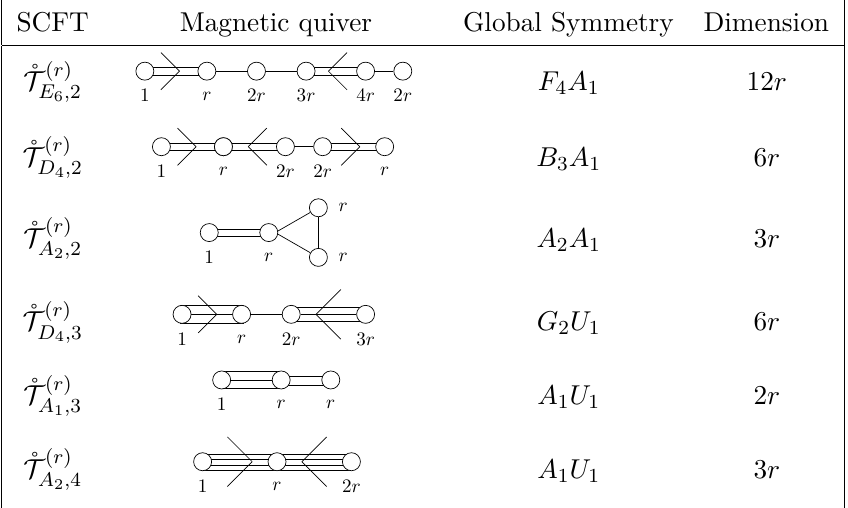
˚ theories with their magnetic quivers. The global symmetry is independent of r . Table 8. The T ( r ) G,‘ The dimension of the Higgs branch is the same as for the corresponding T ( r ) U(1) is ungauged on a long node of all the quivers.